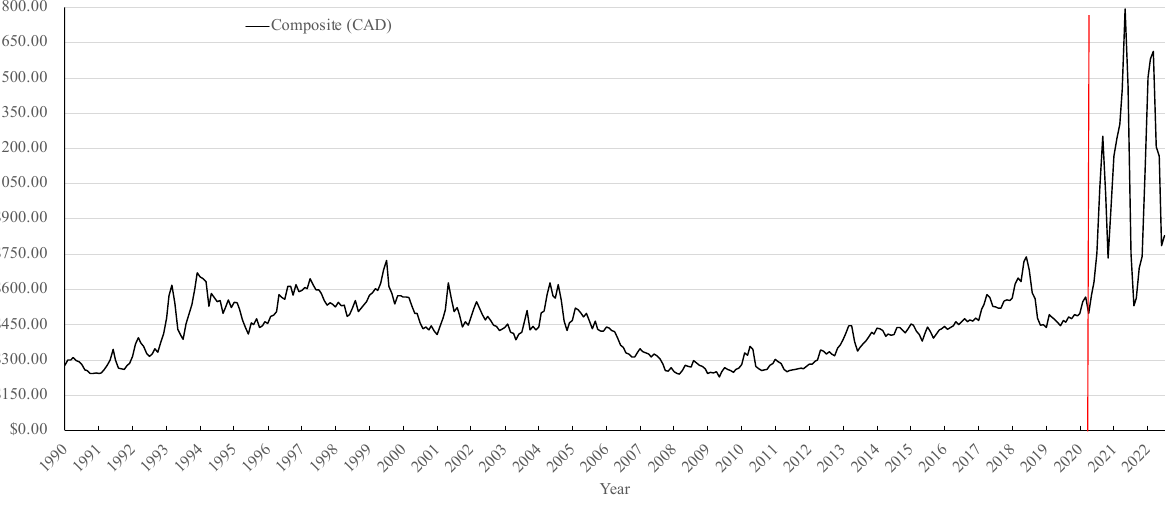
Figure 4. Composite framing price index in CAD January 1980 through July 2022 Source: Statista (2022) and Random Lengths (various issues).